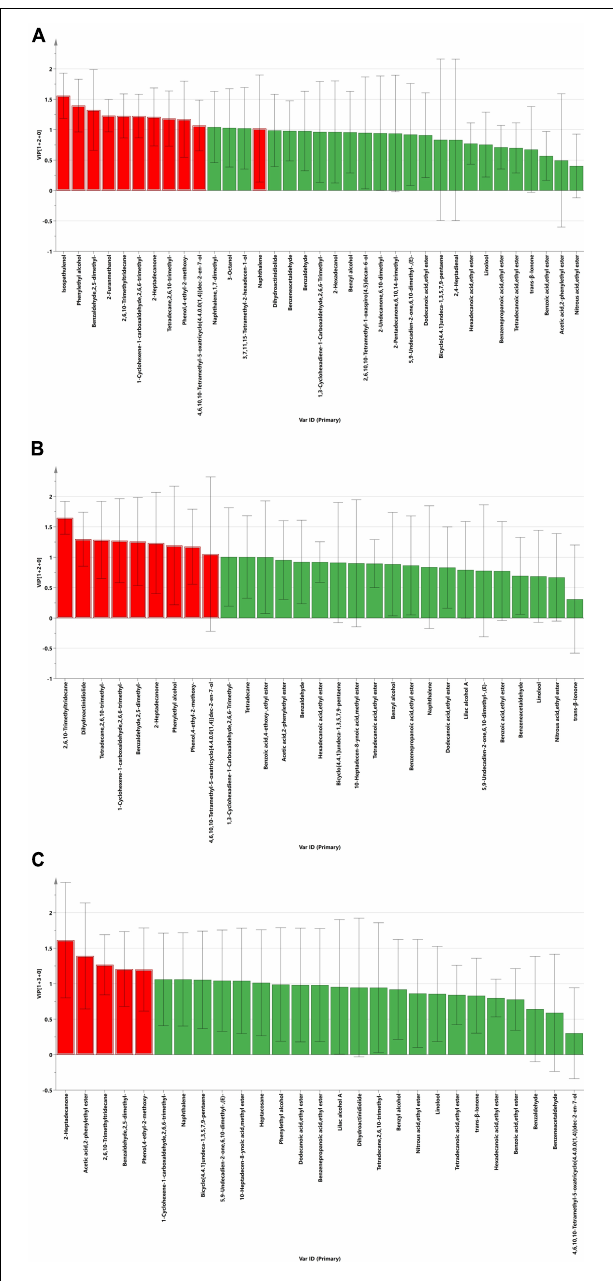
FIGURE 4 | Differences in volatile chemicals between silages treated with LP (A) , LB (B) , and PB (C) compared to silage treated with CK. Volatile chemicals with VIP > 1.0 and P < 0.05 were marked as